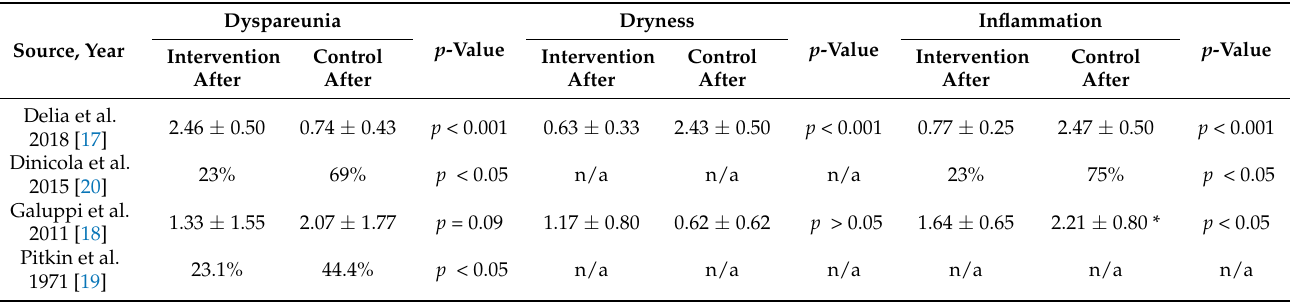
Table 3. Effect of intervention on vaginal